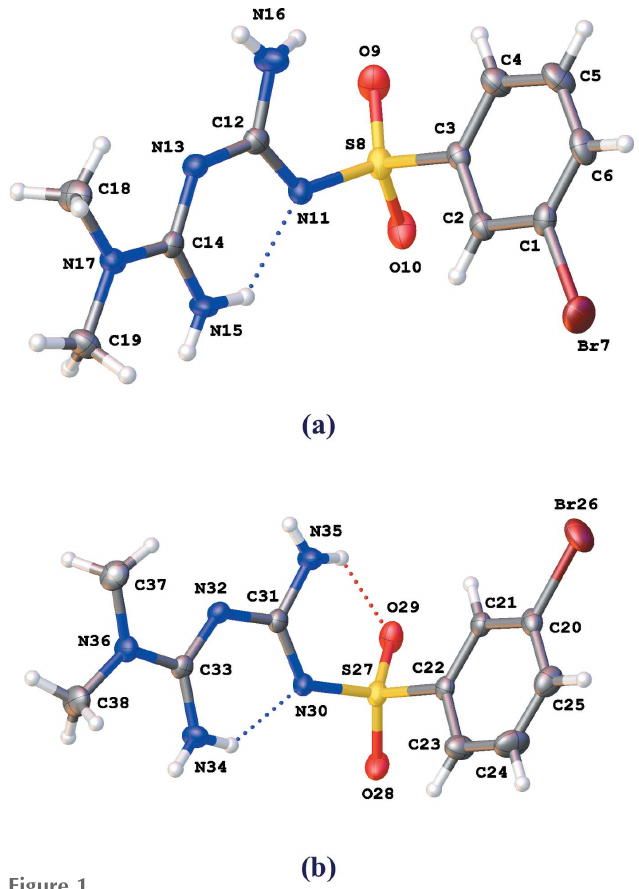
Figure 1 The molecular structure of the two independent molecules ( A and B ) of the title compound, showing the atom labelling scheme. Displacement ellipsoids are drawn at the 30% probability level. Only the major component is shown. Intramolecular interactions are shown as dotted